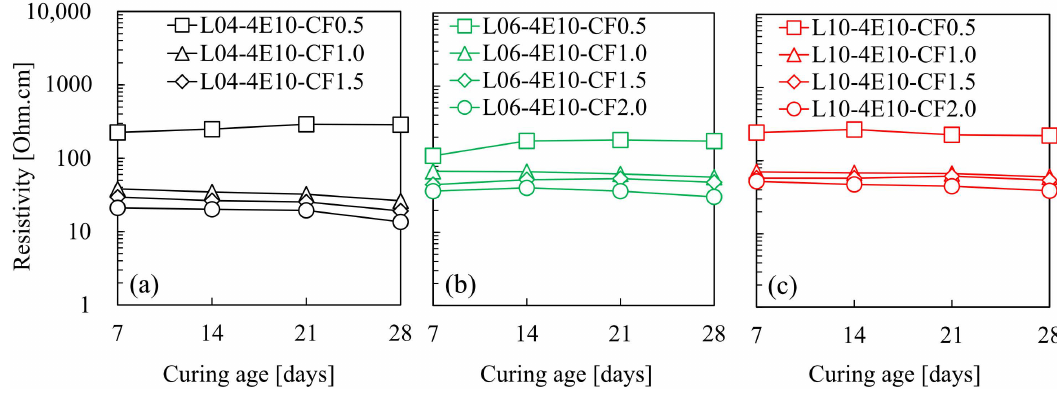
Figure 6. Resistivity of cement composites as a function of the curing age measured via four-probe configuration for di ff erent carbon fiber (CF) contents and electrode spacing of 10 mm (4E10) for CF lengths of ( a ) 4 mm, ( b ) 6 mm, and ( c ) 10 mm. L04, L06, and L10 correspond to the CF lengths of 4, 6, and 10 mm, respectively. CF0.1–2.0 indicate the CF content (0.1–2%) incorporated into the cement composites. Table 3. Resistivity [Ohm · cm] of cement composites as a function of the curing age for the four-probe configuration; each resistivity is the average of 3 test samples, and S.D. stands for standard deviation.